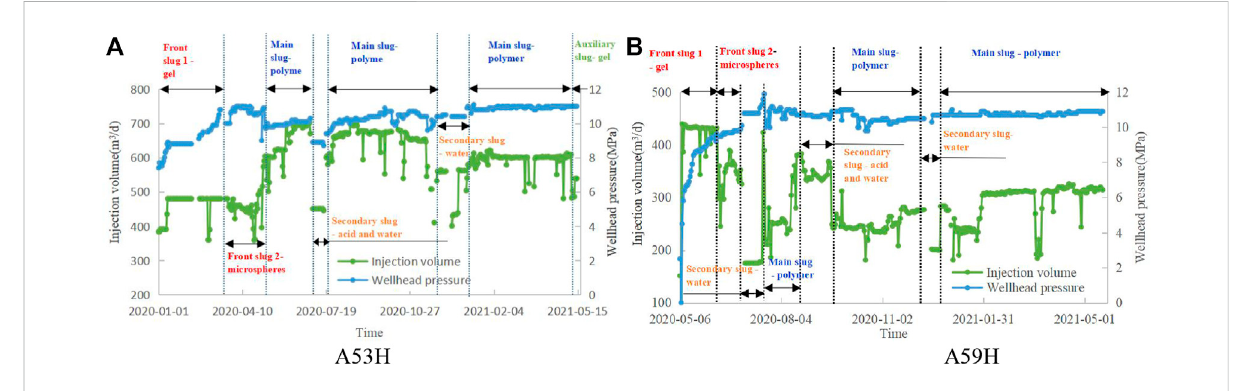
FIGURE 9 Injection performance curve.